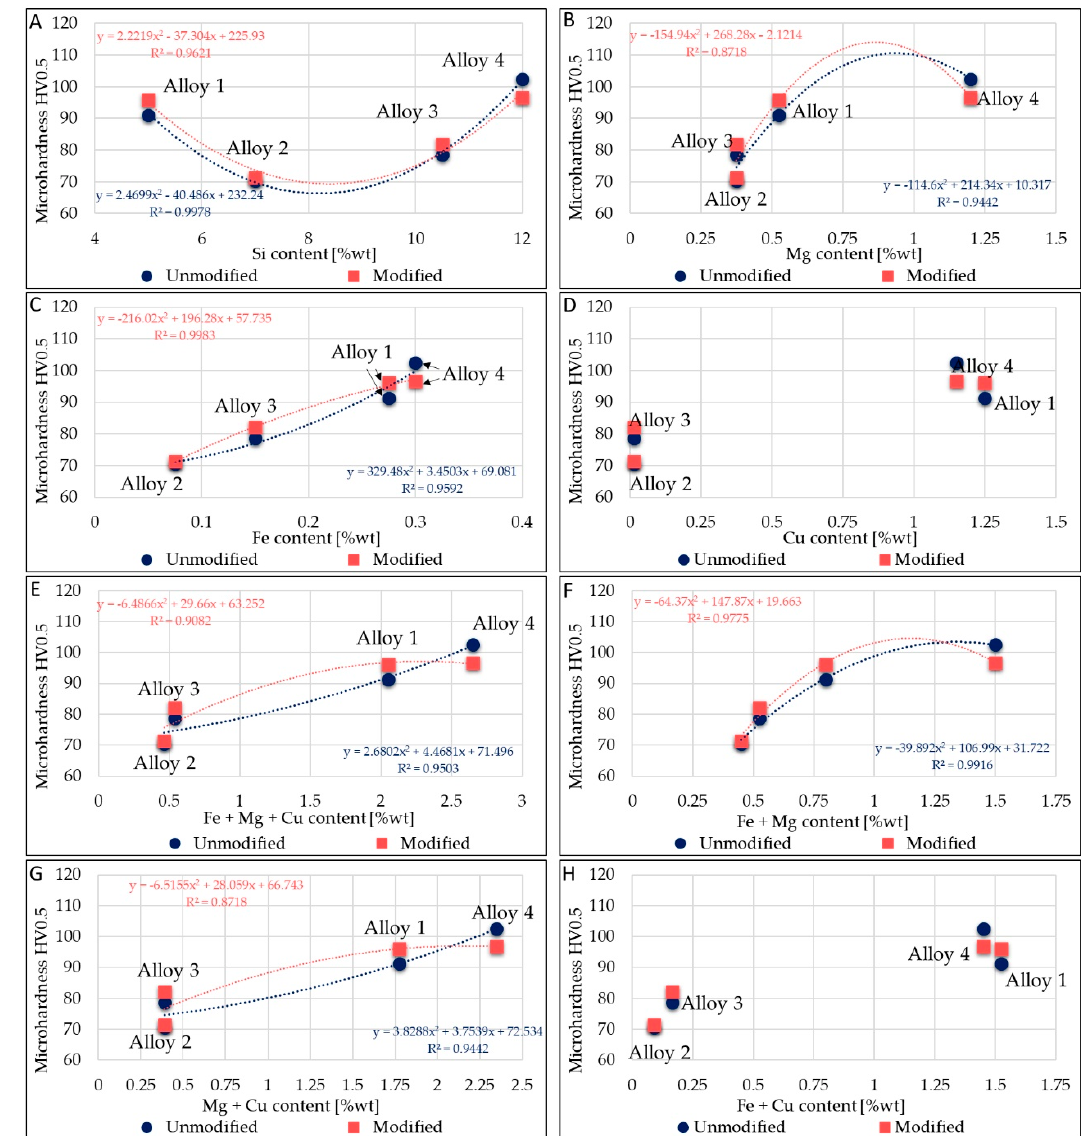
Figure 4. Correlation between micro-hardness and average elements contained in alloys. ( A ). Relation between average Si content and micro-hardness. ( B ). Relation between average Mg content and micro-hardness. ( C ). Relation between average Fe content and micro-hardness. ( D ). Relation between average Cu content and micro-hardness. ( E ). Relation between average Fe + Mg + Cu content and micro-hardness. ( F ). Relation between average Fe + Mg content and micro-hardness. ( G ). Relation between average Mg + Cu content and micro-hardness. ( H ). Relation between average Fe + Cu content and micro-hardness.